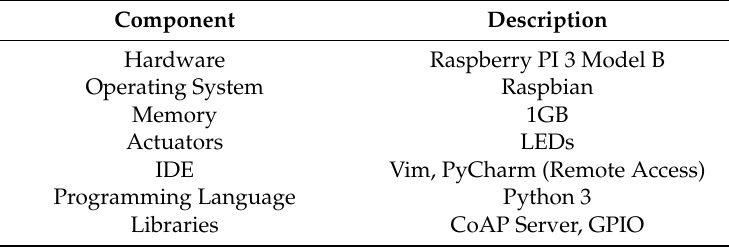
Table 5. Components description of the Raspberry PI.